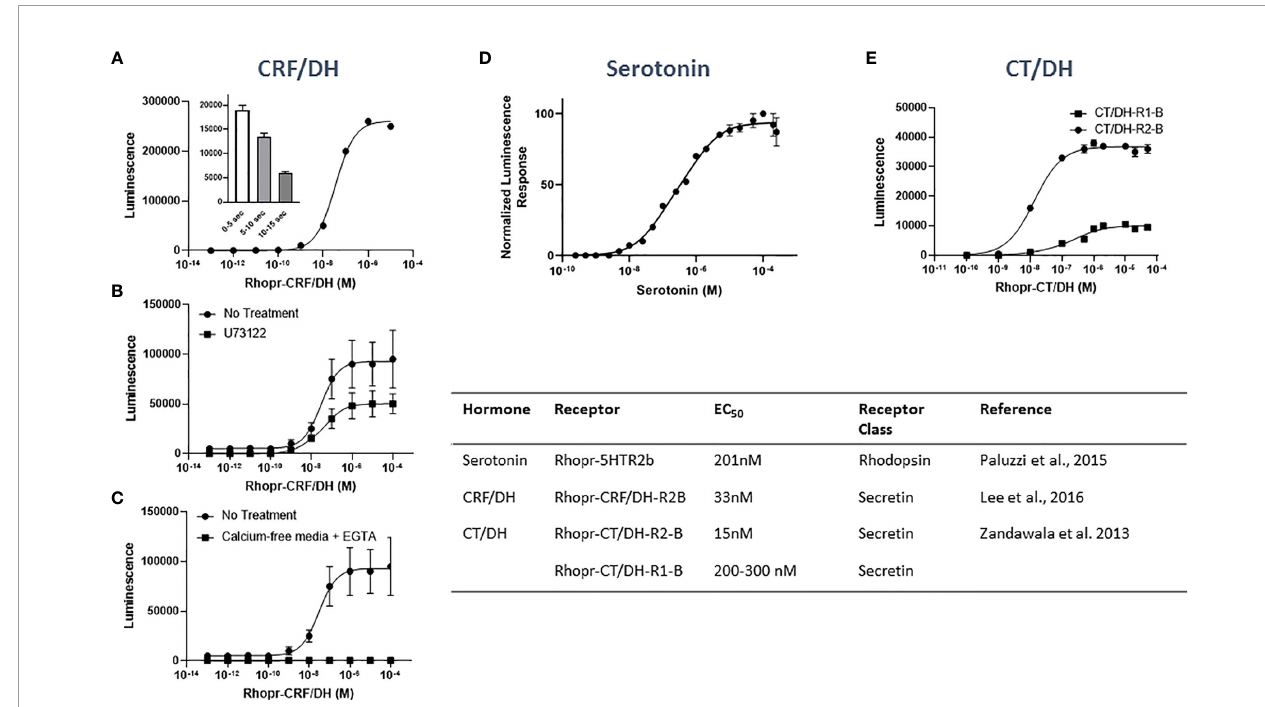
FIGURE 4 | Heterologous functional assay and properties (Table insert) of GPCRs for the diuretic hormones associated with Malpighian tubules of Rhodnus prolixus . (A) Rhopr-CRF/DH-R2B transiently expressed in CHO/G16 cells is dose-dependently activated by Rhopr-CRF/DH. Inset illustrates the kinetics of response to 10 − 5 M Rhopr-CRF/DH in 5 s intervals over a period of 15 s. Note the fast response. (B) Functional assay of Rhopr-CRF/DH-R2B transiently expressed in HEK293/CNG cells. Dose-response curves showing the effect of Rhopr-CRF/DH on Rhopr-CRF/DH-R2B activation in the presence or absence of 10 m M U73122. The response is still evident in the presence of U73122 illustrating that the PLC/IP 3 pathway is not the natural second messenger pathway. (C) Dose-response curves showing the effect of Rhopr-CRF/DH on Rhopr-CRF/DH-R2B activation in the presence or absence of extracellular calcium. Note the response is completely eliminated in the absence of extracellular calcium, illustrating that Rhopr-CRF/DH is naturally elevating cAMP, which in this modi fi ed cell line opens up the cyclic nucleotide-gated (CNG) channel allowing extracellular calcium to enter the cell and be observed through luminescence. (D) Heterologous functional assay of the R. prolixus serotonin type 2b receptor (Rhopr5HTR2b) in CHOK1-aeq cells. Dose-response curve demonstrating activity of serotonin on the expressed Rhopr5HTR2b receptor. (E) Heterologous functional assay of R. prolixus CT/DH receptor isoforms (Rhopr-CT/DH-R1-B and Rhopr-CT/DH-R2-B transiently expressed in HEK293/ CNG cell lines. Dose-dependent effect on the bioluminescence response after addition of Rhopr-CT/DH to HEK293/CNG cells illustrates a much greater response from Rhopr-CT/DH-R1-B. Graphs redrawn from references (30, 38, 39) in the Table